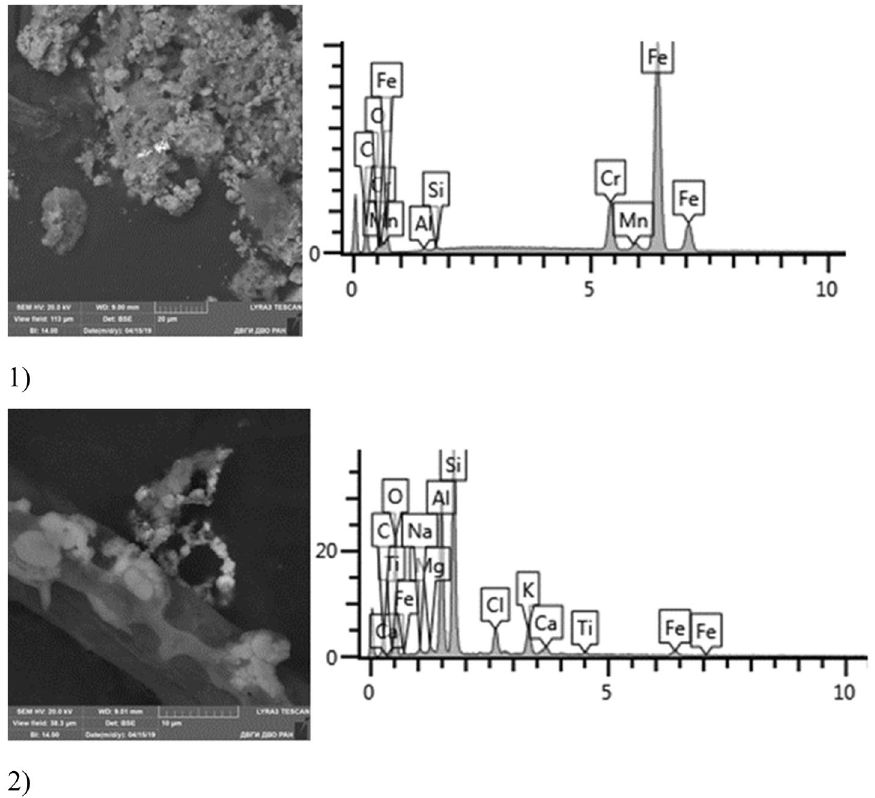
Figure 17. Cadmium plating. Particles morphology. Scanning electronic microscopy. 1) Measuring interval 20 µm, 2) measuring interval 10 µm.